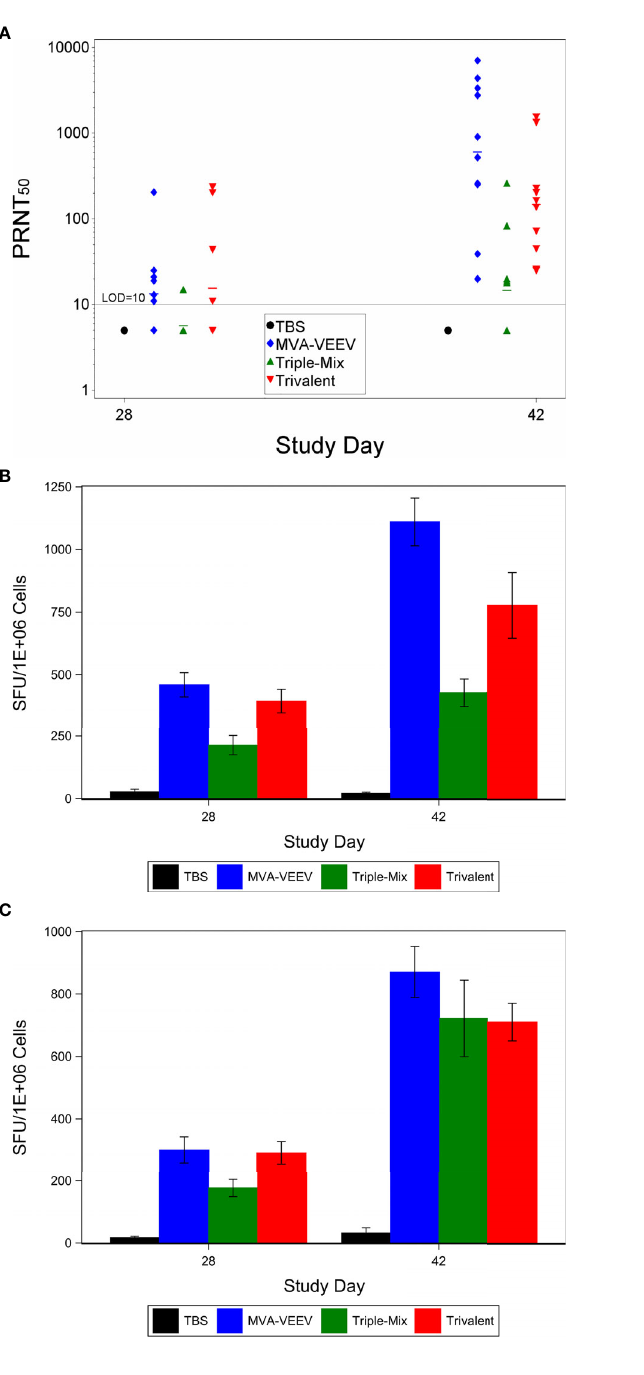
FIGURE 1 | Immune Response After Immunization with MVA-VEEV, Triple Mix, or Trivalent Vaccines. Mice were immunized (IM) twice (Day 0 and 28) with the respective vaccine or TBS. PRNT 50 (A) and Interferon gamma response (ELISpot) to the E1 peptide pool (B) and E2 peptide pool (C) . The second vaccination on Day 28 (Day 42) resulted in a signi fi cant increase in the neutralizing antibody titers compared to Day 28 (p < 0.05) in all three vaccination groups. In addition, the monovalent MVA-VEEV and Trivalent IFN g response was signi fi cantly greater (p < 0.05) than the IFN g response measured at Day 28 (E1 and E2 peptide pool) and Day 42 for the Triple-Mix group (E1 peptide pool). Ten animals per group were evaluated at each time point. (A) horizontal lines represent group mean values. Standard error of the mean is included in (B, C)